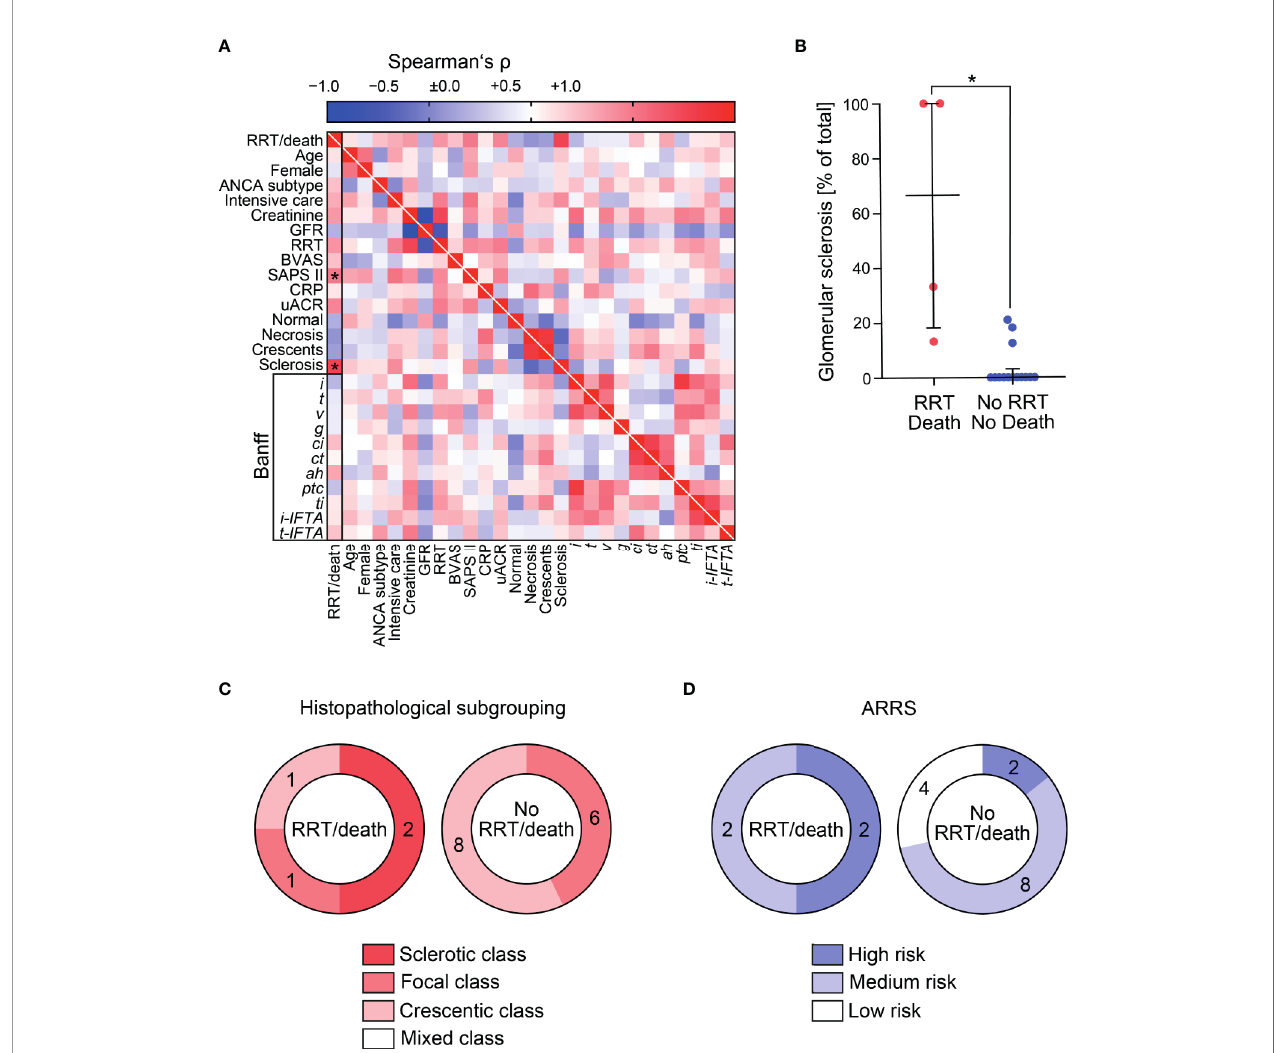
FIGURE 4 | Determinants of short-term outcomes in patients with severe AAV receiving PEX treatment de fi ned by the requirement of RRT at day 30 after admission or death within 30 days after admission. (A) Association with short-term outcome of patients with severe AAV receiving PEX treatment de fi ned by requirement of RRT at day 30 after admission or death within 30 days after admission are shown by heatmap re fl ecting mean values of Spearman ’ s r , asterisks indicate p <0.05 . (B) The scatter dot plots represent medians and IQR with individual data points summarizing association between short-term outcome of patients (RRT/death) and indicated histopathological fi ndings, Mann – Whitney U-test was used to determine differences in medians and asterisks indicate p <0.05 . (C, D) Association between short-term outcome of patients (RRT/death), histopathological subgrouping and ARRS are shown. AAV, ANCA-associated vasculitis; ANCA, anti-neutrophil cytoplasmic antibodies; BVAS, Birmingham Vasculitis Activity Score; CRP, C-reactive protein; GFR, glomerular fi ltration rate (CKD-EPI); IF/TA, interstitial fi brosis/ tubular atrophy; IQR, interquartile range; PEX, therapeutic plasma exchange; RRT, renal replacement therapy; SAPS II, simpli fi ed acute physiology score II; uACR, urinary albumin/creatinine